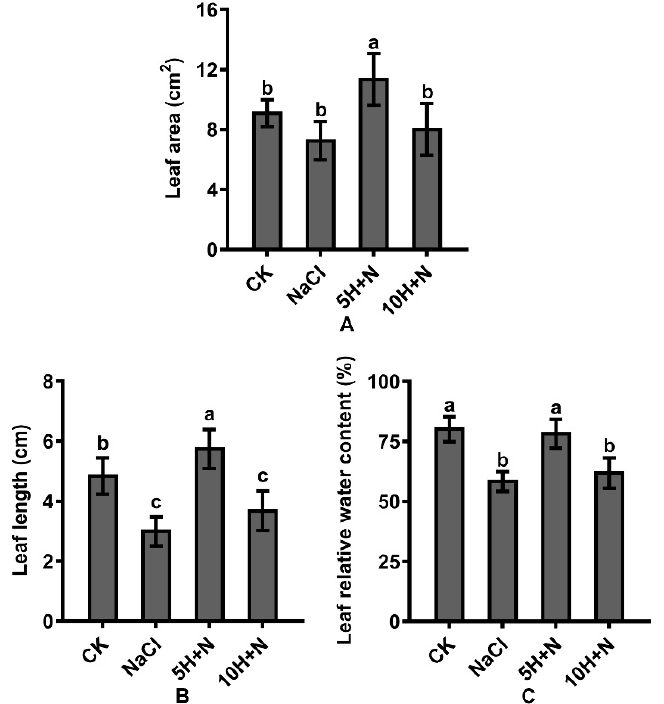
Figure 3. Effects of exogenous H 2 O 2 on LA ( A ), LL ( B ), and LRWC ( C ) of Tartary buckwheat under NaCl stress. CK: control, H 2 O foliar spray + H 2 O irrigation, NaCl: H 2 O foliar spray + 150 mmol · L − 1 NaCl irrigation, 5H + N: 5 mmol · L − 1 H 2 O 2 foliar spray + 150 mmol · L − 1 NaCl irrigation, 10H + N: 10 mmol · L − 1 H 2 O 2 foliar spray + 150 mmol · L − 1 NaCl irrigation. LA: leaf area (cm 2 ), LL: leaf length (cm), LRWC: leaf relative water content (%). All values are expressed as mean ± SD. According to Duncan’s multiple comparisons, different letters represent significant differences among different treatments ( p < 0.05).